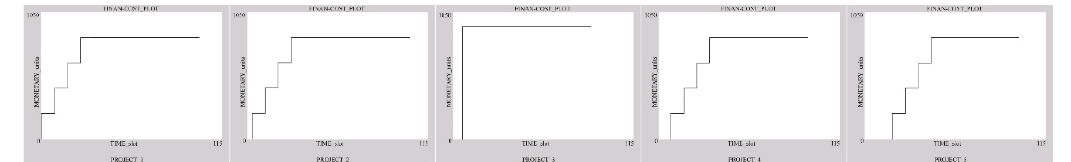
Fig. 6. Funding curves defined in the first experiment. Project 3 is given a high funding to acceler- ate its schedule